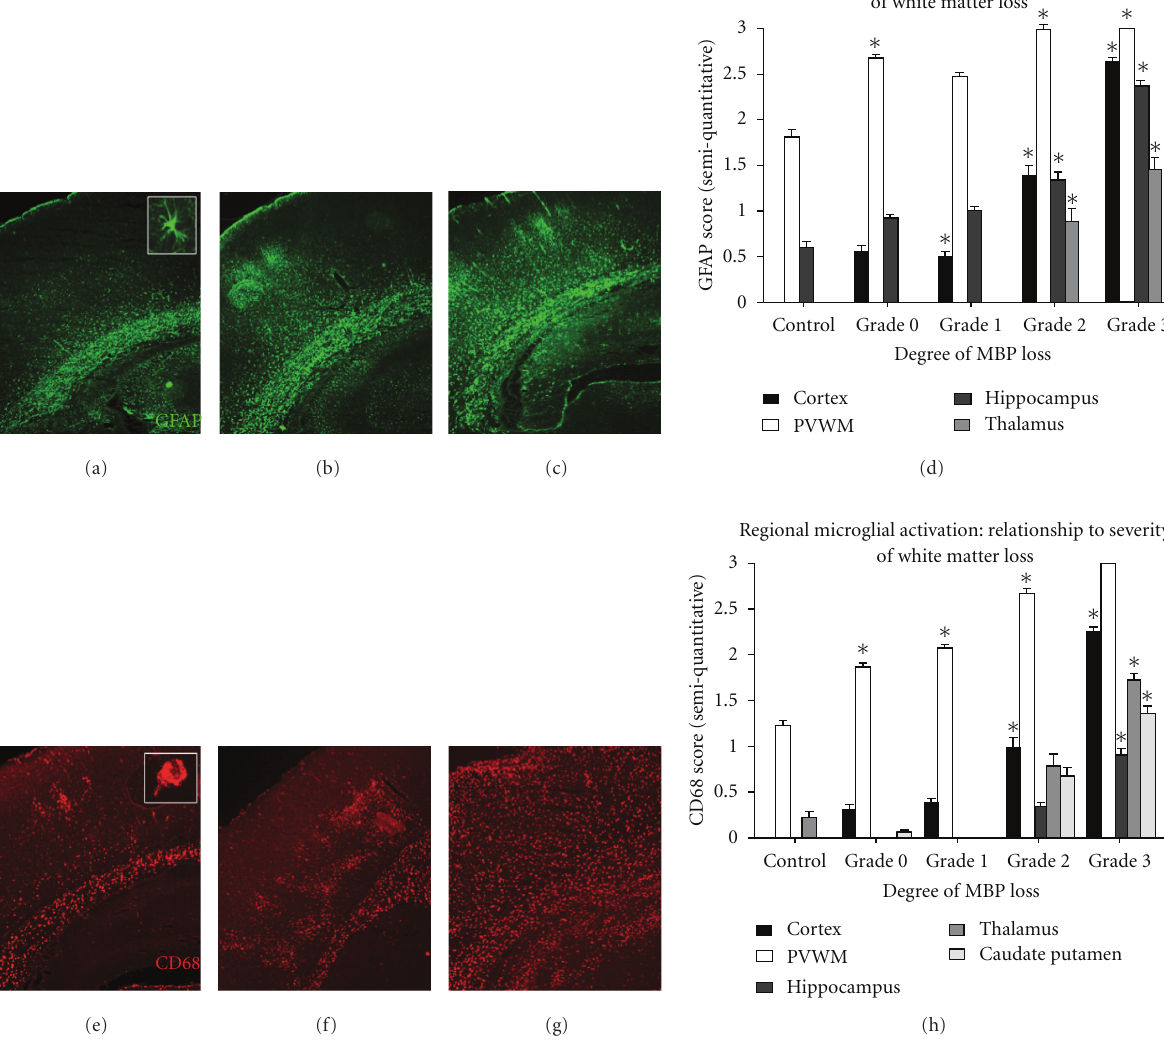
Figure 2: Astrogliosis and microgliosis in relation to severity of white matter injury in hypoxic-ischemic (HI) neonatal rats. Seventy-two hours following HI at postnatal day 6 (P6), numerous reactive astrocytes (a–d) and activated microglia (e–h) are present throughout the brains of neonatal rats with significant white matter injury. Representative photomicrographs depict GFAP-positive astrocytes and mild (a), moderate (b), and severe (c) astrogliosis following HI. Histogram in (d) displays the region-specific pattern and degree of reactive astrocytosis as a function of MBP loss. Lower panels depict CD68-positive microglia and mild (e), moderate (f), and severe (g) microgliosis following HI. Histogram in (h) shows the region-specific pattern and degree of microglial activation as a function of white matter injury severity. Magnification